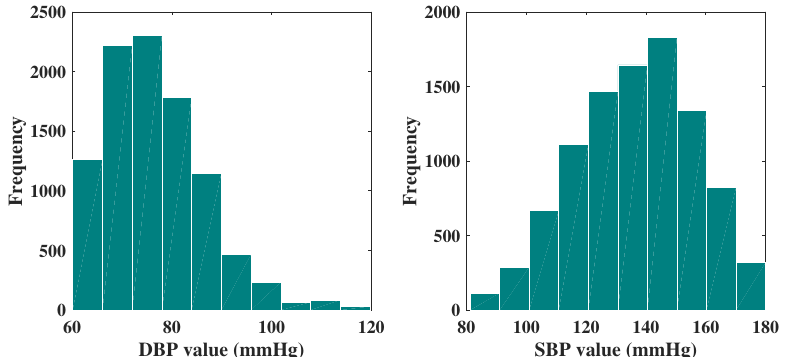
Figure 4. Histogram of DBP values and SBP values in the final data